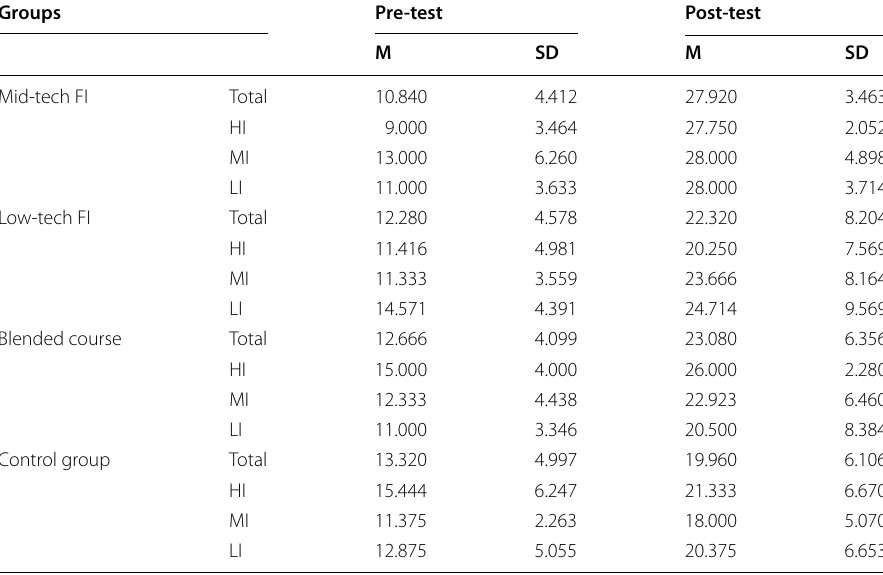
HI high impulsive, MI moderate impulsive, LI low impulsive (reflective)